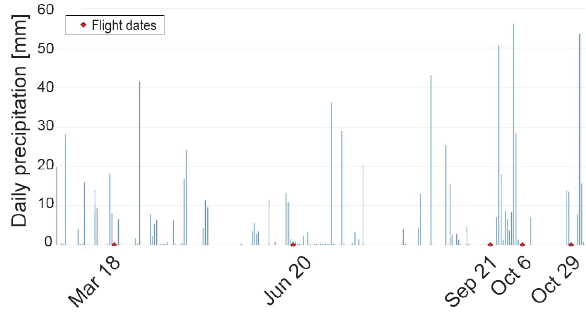
Figure 2: Flight dates and daily precipitation between Mar 1, 2015 and Oct 31, 2015 for Lake Wheeler Rd. Field Lab Station